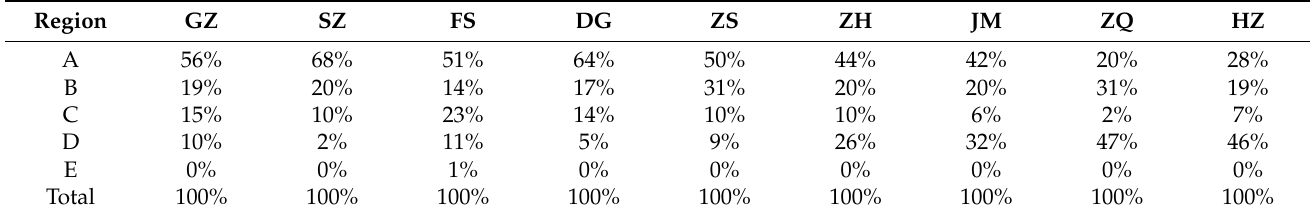
Table 4. Area proportion of different types of regions.